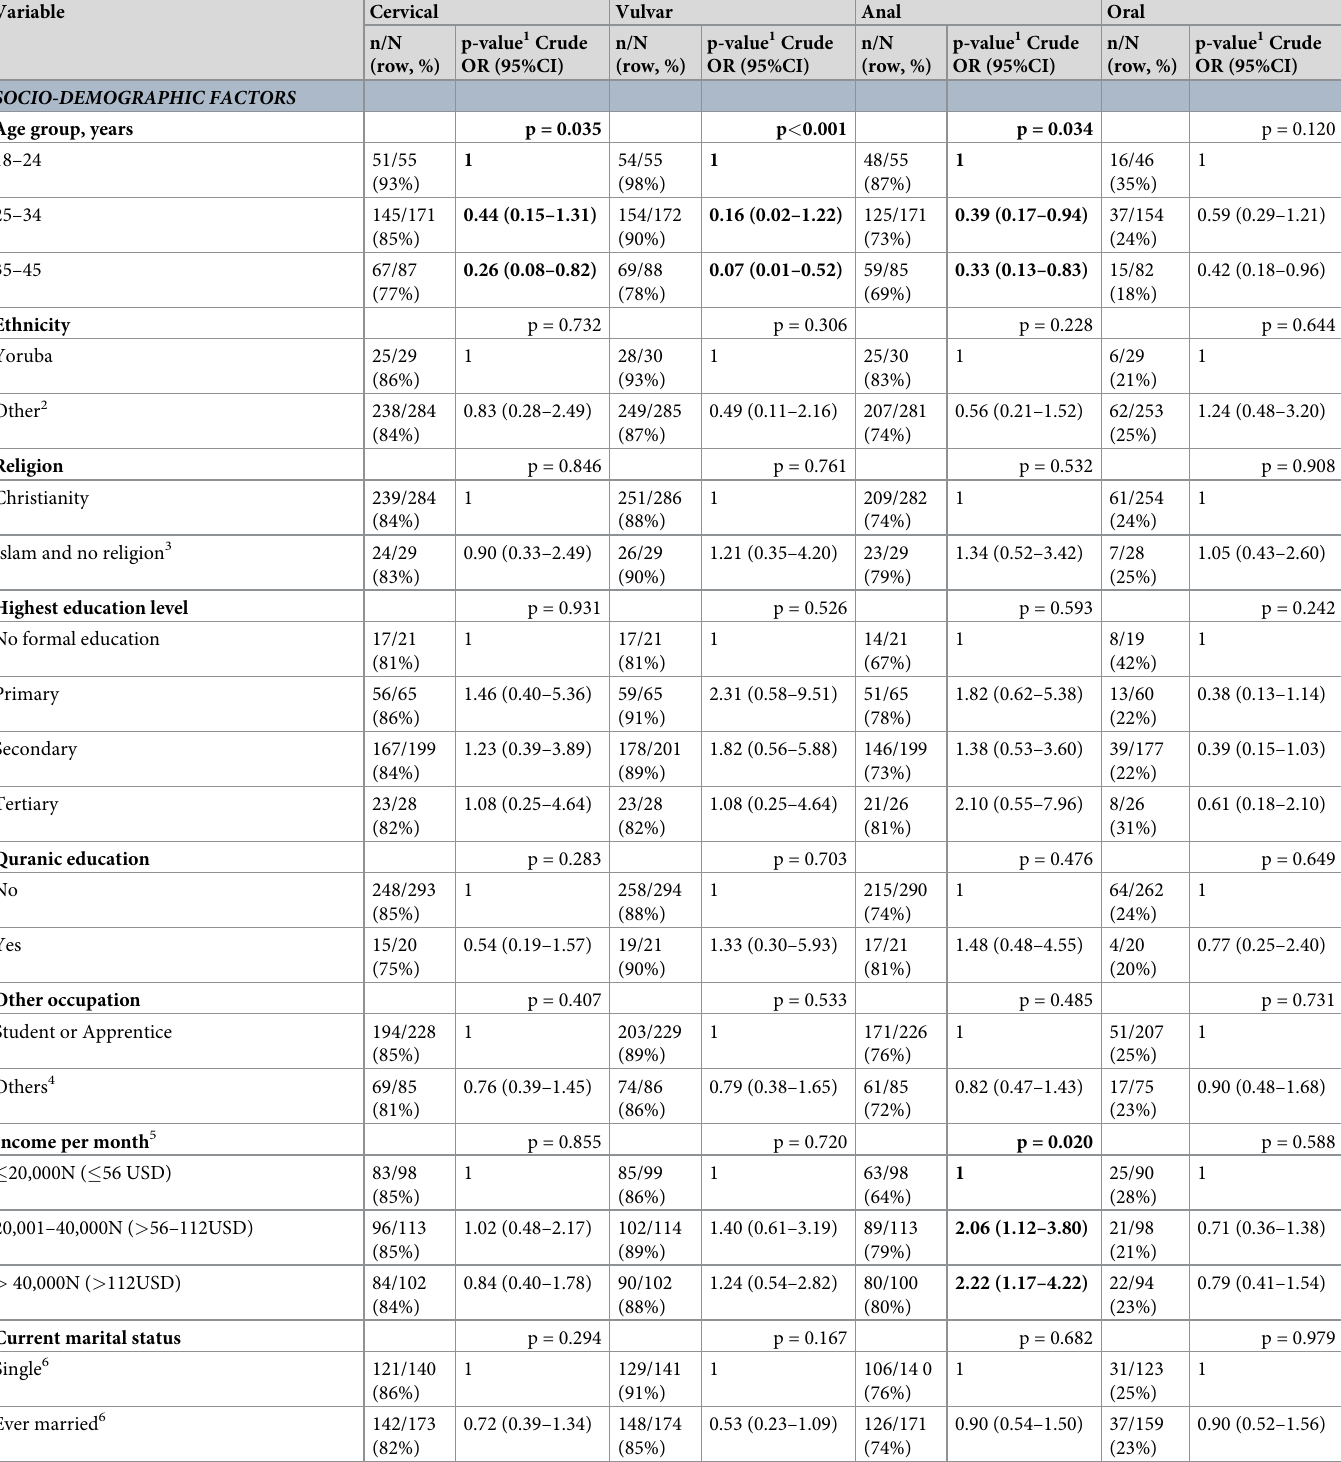
Table 3. Descriptive summaries and unadjusted factors associated with cervical, vulvar, anal and oral human papillomavirus infection among brothel-based female sex workers in Ibadan,